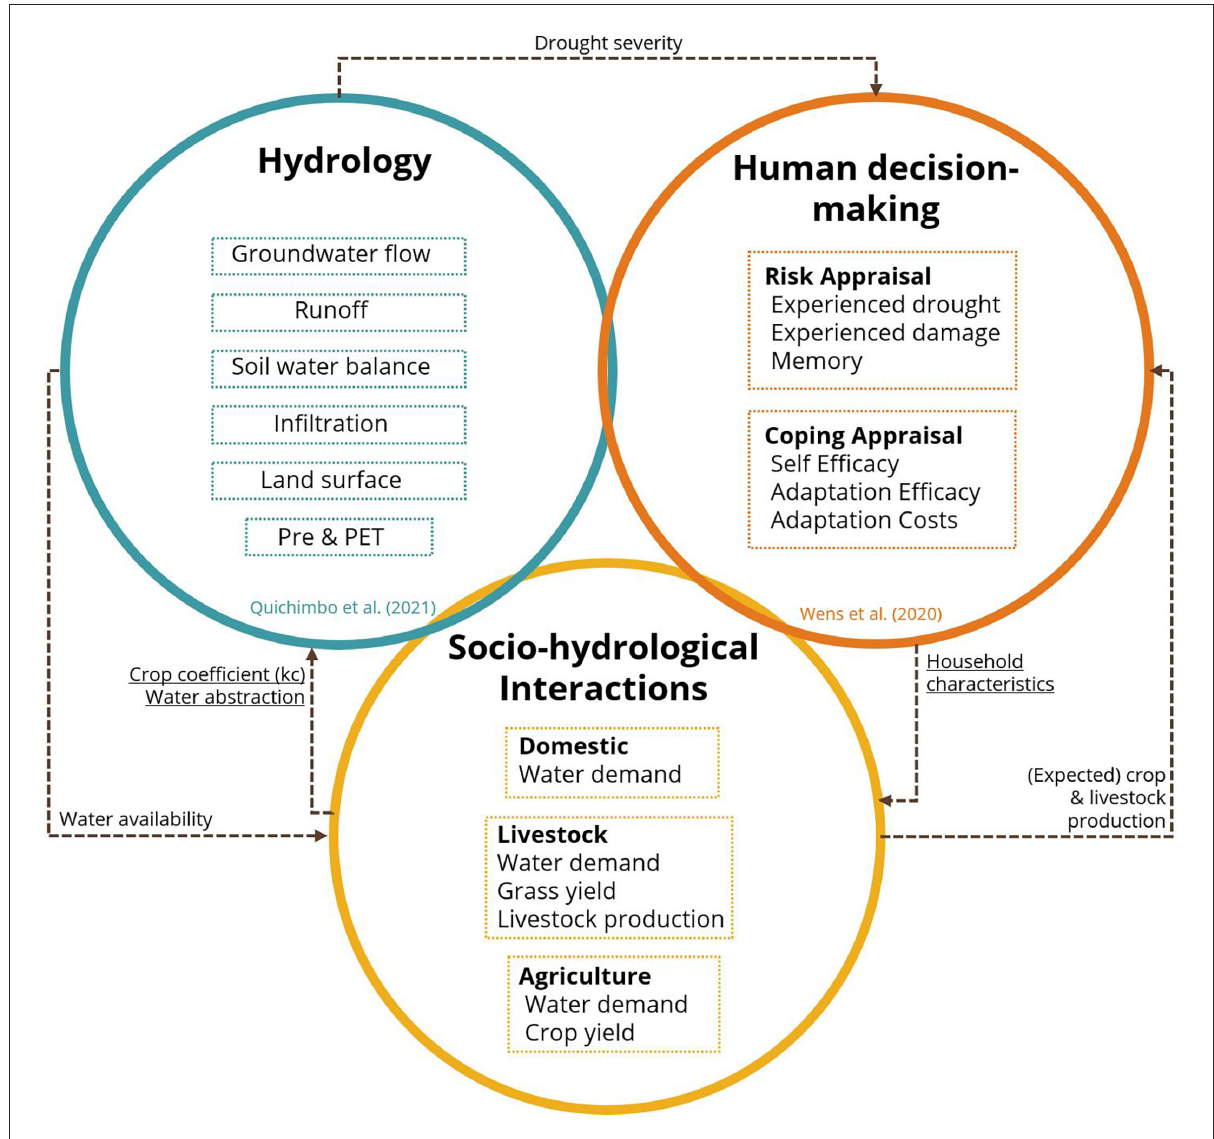
FIGURE1 ADOPT-AP framework and interactions between environment (DRYP hydrological model), human decision-making (ADOPT) and socio-hydrological interactions. The linkages show how the different components are